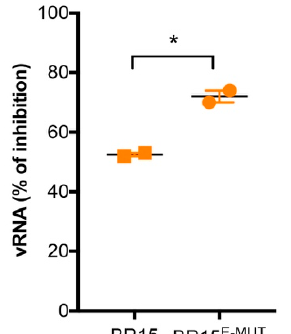
Figure 4. Viral fusion in A549-Dual™ cells. Pre-chilled cells were incubated at 4 °C with ZIKV at MOI of 1. After 1-h incubation, cells were shifted to 37 °C. Chloroquine was then added to the culture medium. Viral RNA was measured by RT-qPCR 30 h at 37 °C. Error bars represent standard errors of two independent experiments. *: p value < 0.1